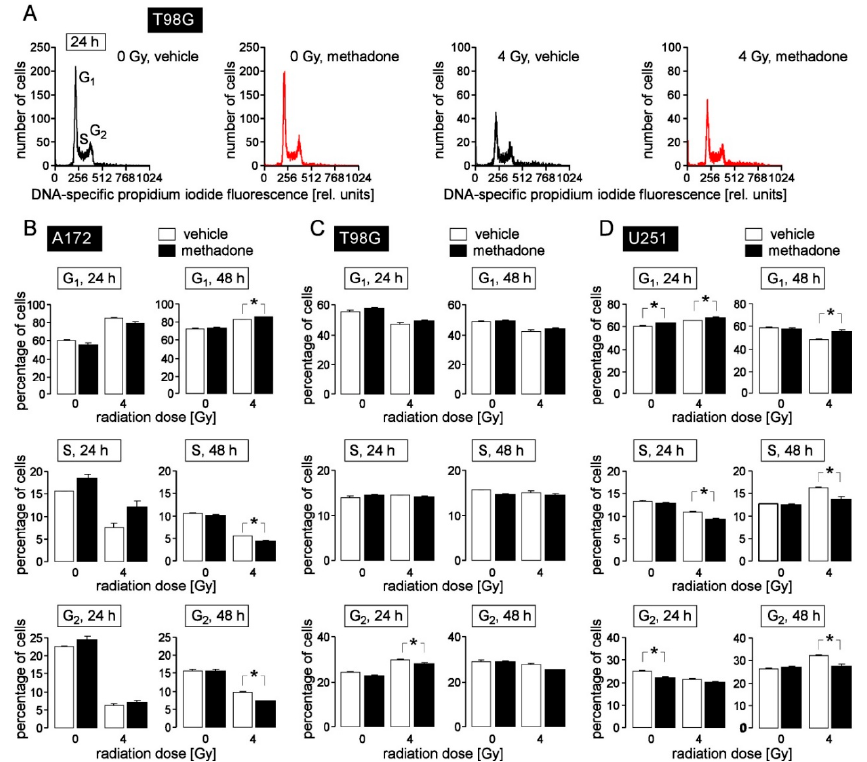
Figure 3. High-dose methadone (20 µM) may modify cell cycle progression in human glioblastoma cells. ( A ) Histograms of permeabilized, propidium iodide-stained T98G glioblastoma cells recorded by flow cytometry (Nicoletti protocol) 24 h after irradiation with 0 Gy ( left ) or 4 Gy ( right ). Cells were pre- (1 h) and co-incubated (24 h) either with 0 µM (vehicle, black) or 20 µM (red) methadone. ( B – D ) Mean (± SE, n = 6) percentage of A172 ( B ), T98G ( C ) and U251 ( D ) glioblastoma cells that reside in G 1 (upper row), S (middle row) and G 2 (lower row) phase of cell cycle 24 h ( left ) and 48 h ( right ) after irradiation with 0 or 4 Gy. Cells were pre-incubated (1 h), irradiated and post-incubated (24 or 48 h)